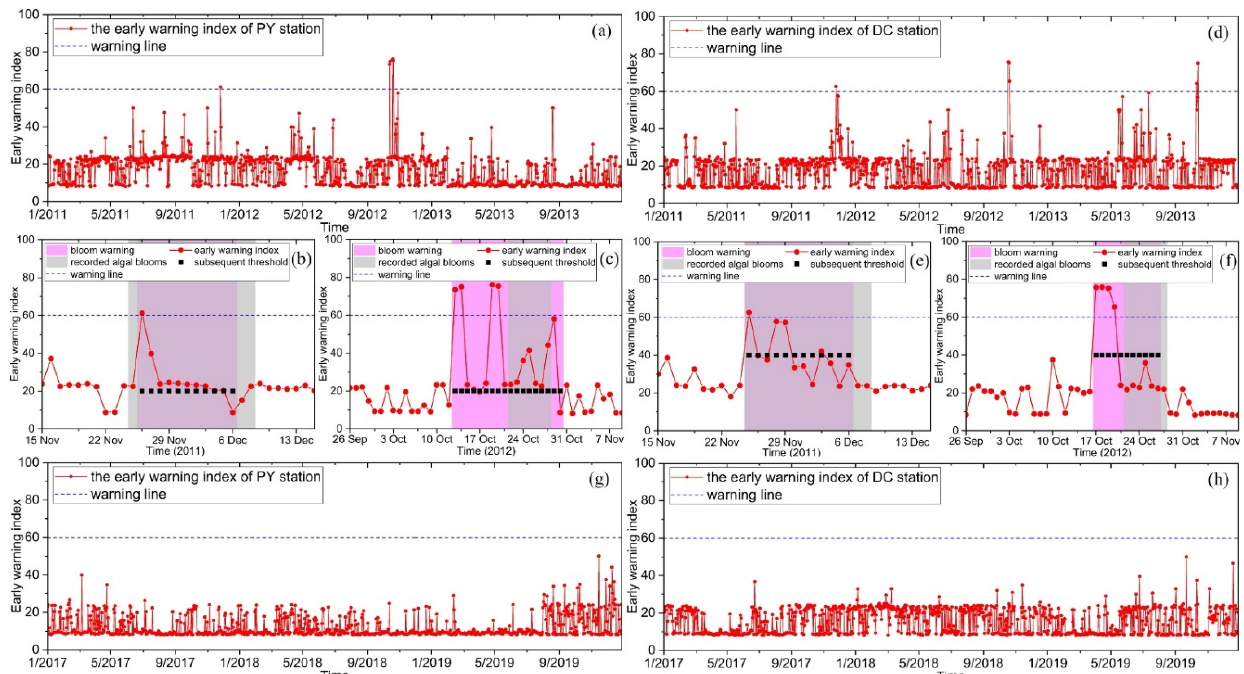
Figure 5. The early warning indexes for PY Station ( a ) and DC station ( d ) from 2011 to 2012. Enlarged views of the two bloom periods are plotted for PY station ( b , c ) and DC station ( e , f ). The early warning indexes for the PY ( g ) and DC ( h ) stations are plotted for 2017–2019 when the blooms were absent. The onset threshold of the value 60 of the warning index is marked by blue dashed lines for the PY station ( a , g ) and DC station ( d , h ). In the enlarged views of bloom period ( b , c , e , f ), the recorded bloom periods are marked by grey shadows. The duration time of the bloom warning is depicted by pink shadows. The selected subsequent thresholds are shown in black crosses. The onset threshold (60) is depicted by a blue dashed line.